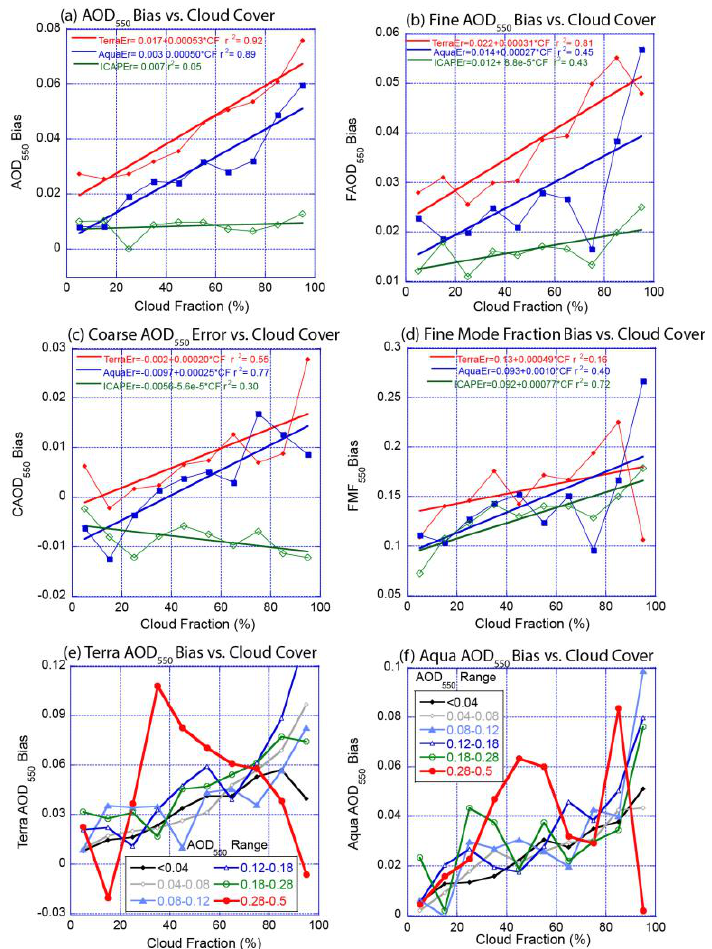
Figure 11. Diagnostic mean bias of ( a ) Total, ( b ) Fine, and ( c ) Coarse Aerosol optical depth for Terra MODIS, Aqua MODIS, and the ICAP C4C as a function of that retrieval’s cloud fraction. ( d ) Likewise diagnostic mean bias for fine mode fraction. ( e , f ) Total AOD 550 bias for Terra and Aqua as a function of that retrieval’s cloud fraction for different AOD 550 ranges.